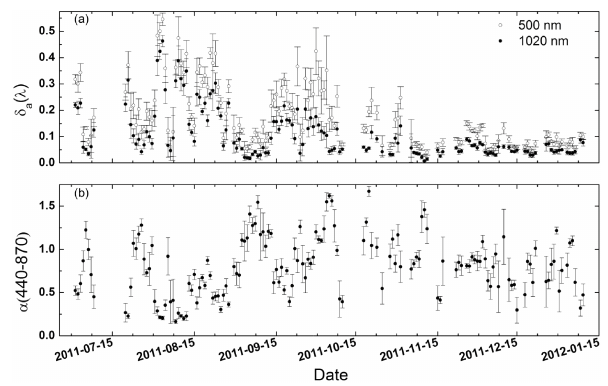
Figure 2. Temporal evolution of the daily mean values of (a) aerosol optical depth at 500 and 1020nm and (b) the Ångström exponent calculated in the range 440–870nm, measured at Alborán Island in the western Mediterranean from 1 July 2011 to 23 January 2012. The error bars are standard